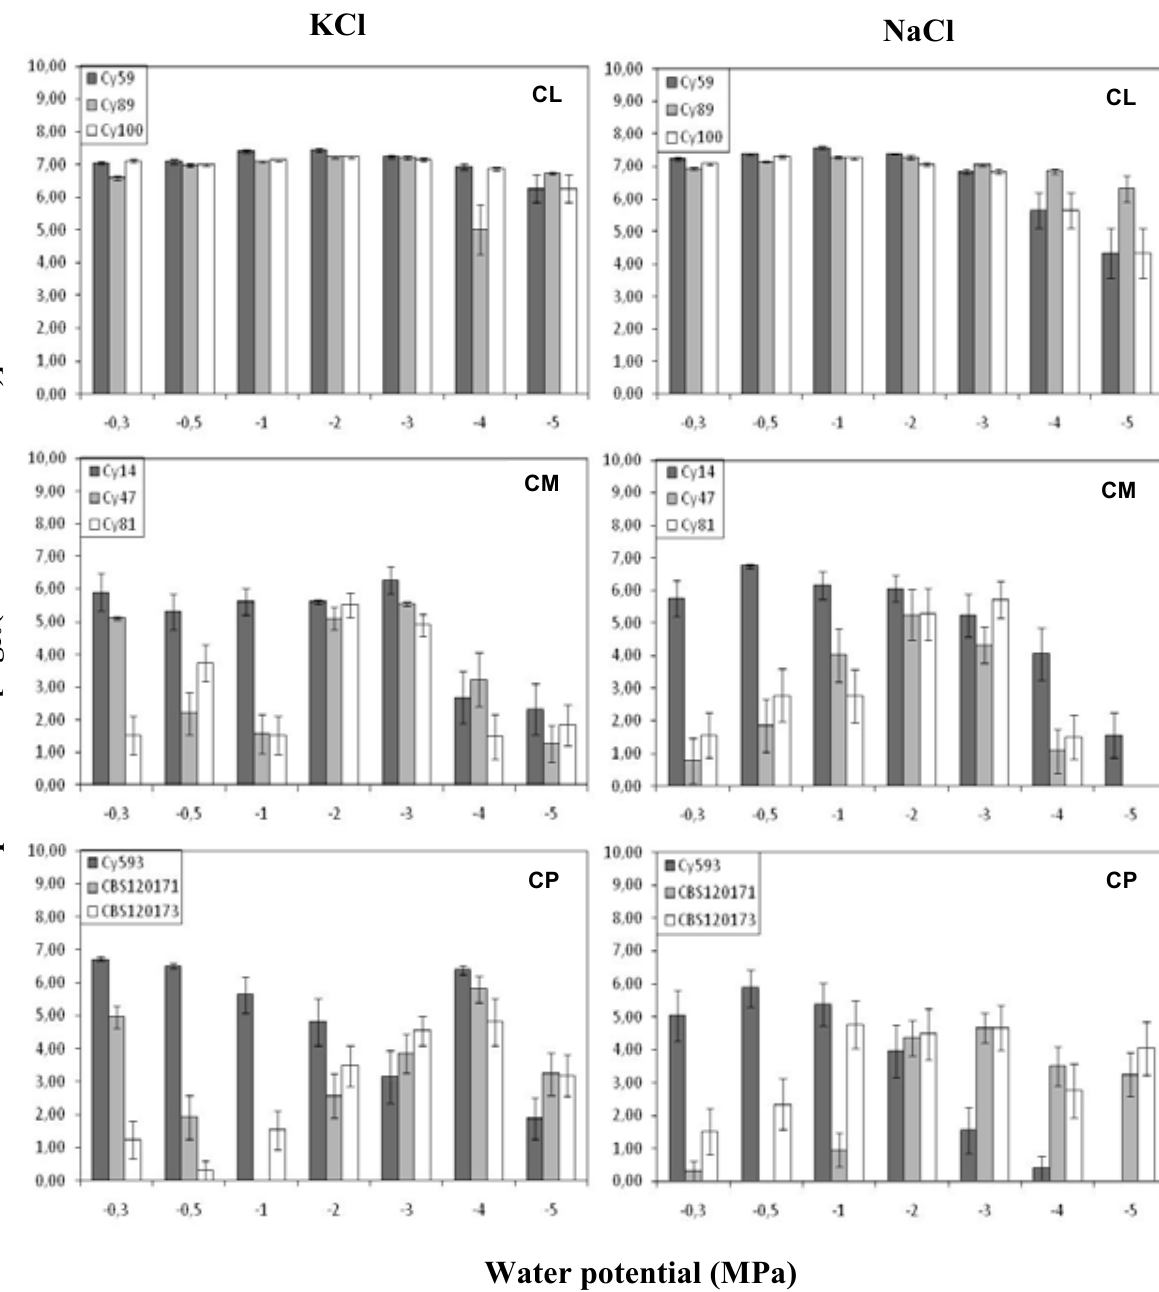
Figure 4. Mean amounts of sporulation [log -2 + 1)] of three isolates of C. liriodendri (CL) , C. macrodidymum 10 (conidia mm (CM) and C. pauciseptatum (CP), after 30 days in darkness at 25ºC on PDA amended with KCl or NaCl to give the follow - ing water potentials -0.5, -1, -2, -3, -4 or -5 MPa . The water potential of nonamended PDA was -0.3MPa. Data points are the means of two independent sets of four pseudoreplicates in each experiment. Vertical bars are the standard error of the